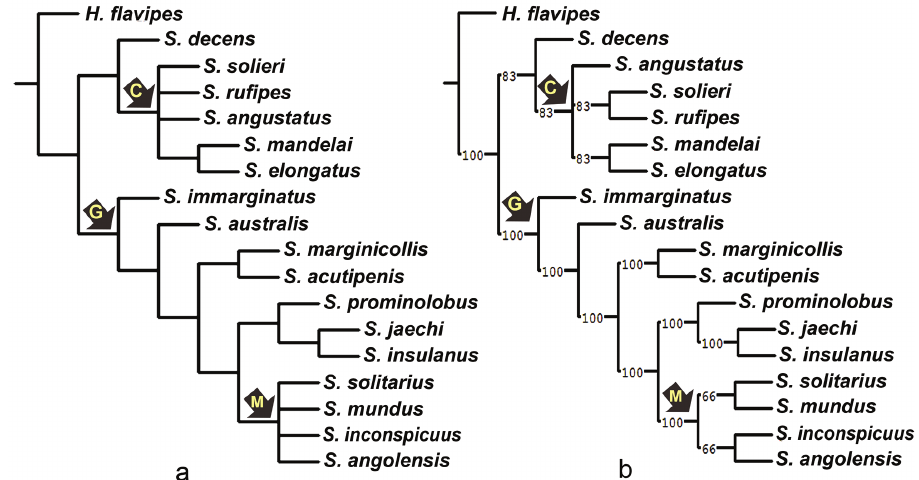
Figure 23. Results of the phylogenetic analysis based on 60 (continuous and discrete) morphological characters, with a suboptimum value of 0.5 step longer a strict consensus tree b majority-rule consensus tree of six most parsimonious trees (length 146.130), numbers on the branches indicate majority rule sup- port for node. The arrows with capital letters indicate selected